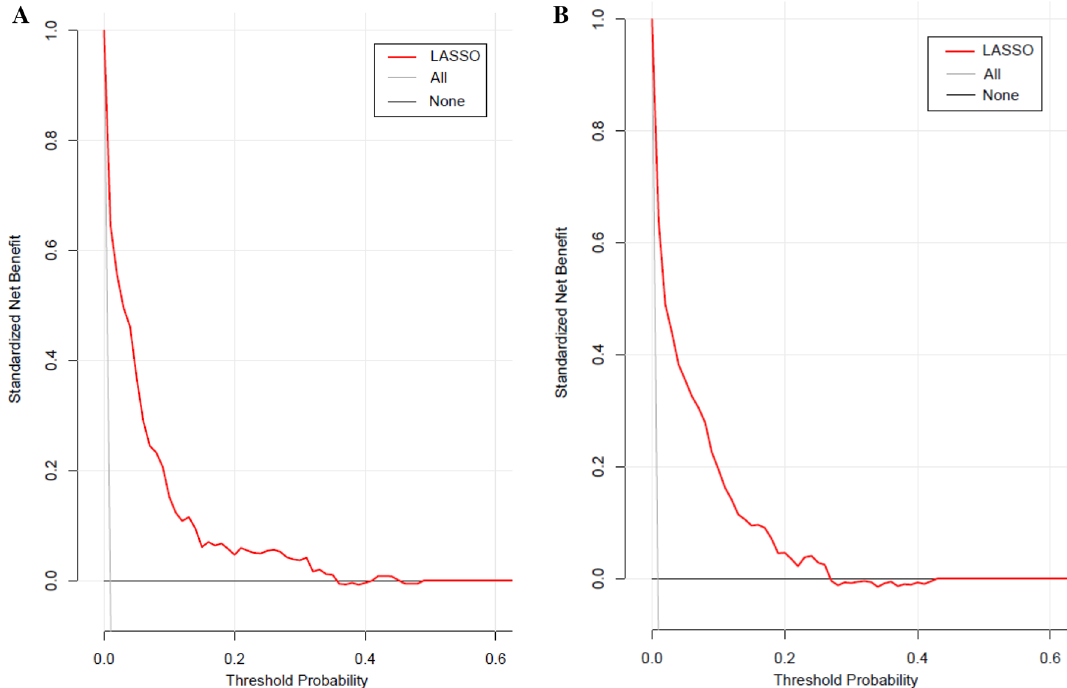
to develop diabetes, while the light gray line represents the net benefit when all participants are considered to develop diabetes. The area between the "no treatment line" (black line) and "all treatment line" (light gray